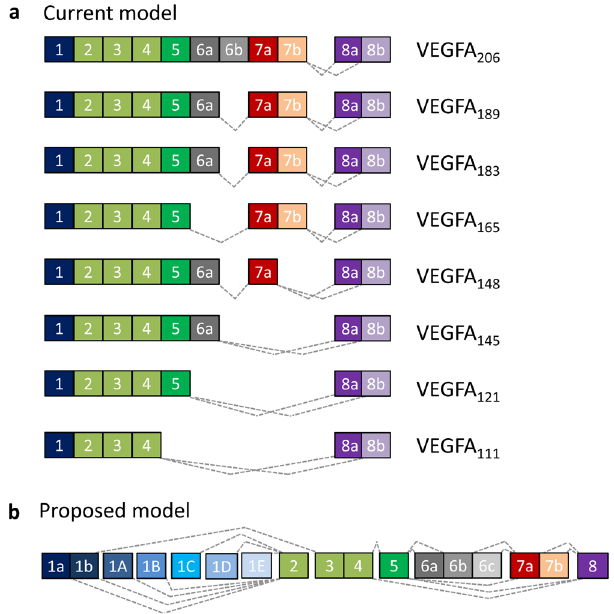
Figure 1. Overview of VEGFA splicing. In the current model exons 1-4 are present in all VEGFA mRNA transcripts. Inclusion or exclusion of different combinations of exons 5 to 7, or variants thereof, creates transcripts encoding VEGFA peptides of differing lengths (indicated by subscript numbers) and biological properties. It has been suggested that use of an alternative 3 ′ splice site for exon 8 can result in a shorter terminal exon (8b) encoding a peptide of the same length but with a different C-terminus which bestows anti-angiogenic properties. Numerous VEGFA xxx b variants have been reported, including VEGFA 111b55 ; VEGFA 165b8 ; VEGFA 121b , VEGFA 183b , VEGFA 145b34 ; VEGFA 189b56 and VEGFA 206b57 . Based upon the analysis of RNA-Seq data presented in this study, we propose an even more complex model for VEGFA transcription which includes alternative first exons and additional splicing events (a novel exon 6 splice site creates exon 6b and the existing exon 6b is renamed 6c). There is a single exon 8 with no splicing to the 8b